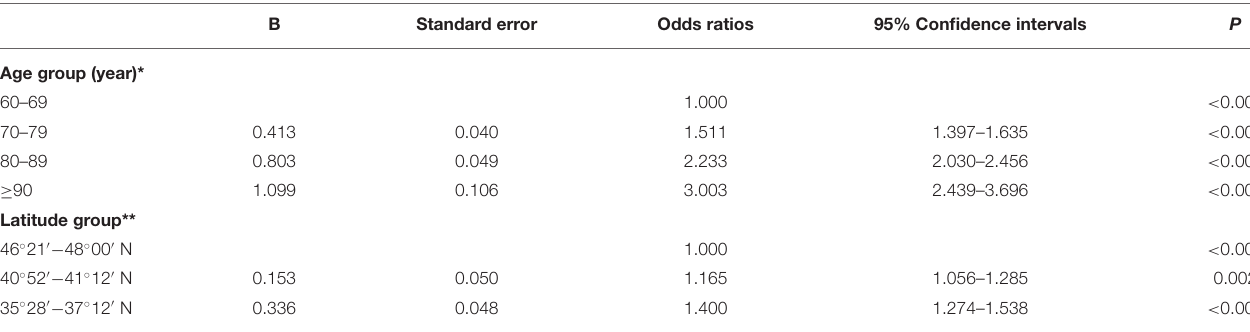
* The odds ratios for age grouping are adjusted for latitude, sex, ethnic group, hypertension, diabetes, hyperlipemia, smoking and drinking status. ** The odds ratios for latitude grouping are adjusted for age, sex, ethnic group, hypertension, diabetes, hyperlipemia, smoking and drinking status. BMI, body mass